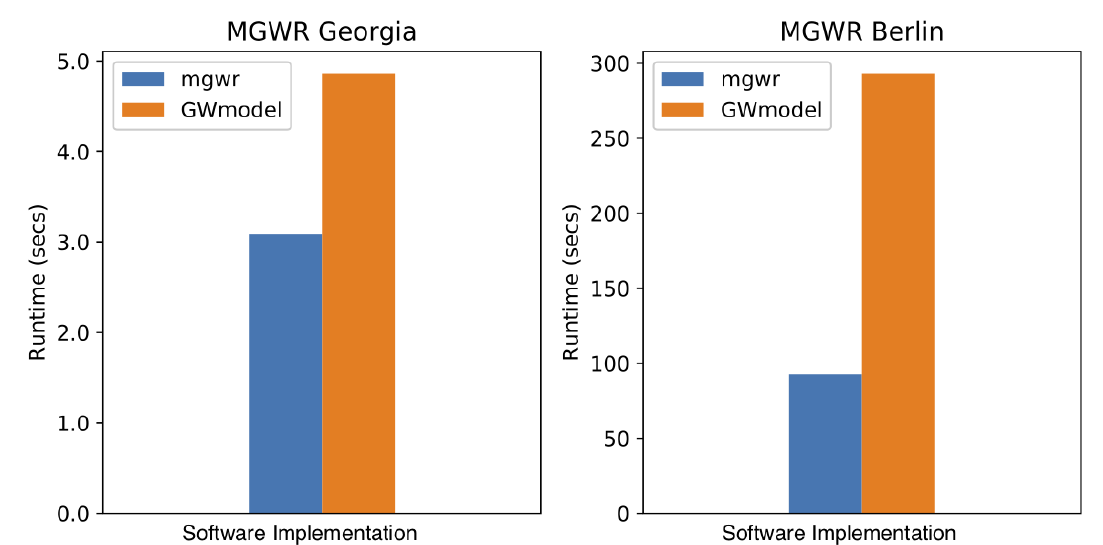
Figure 16. MGWR runtime comparison between mgwr and GWmodel software